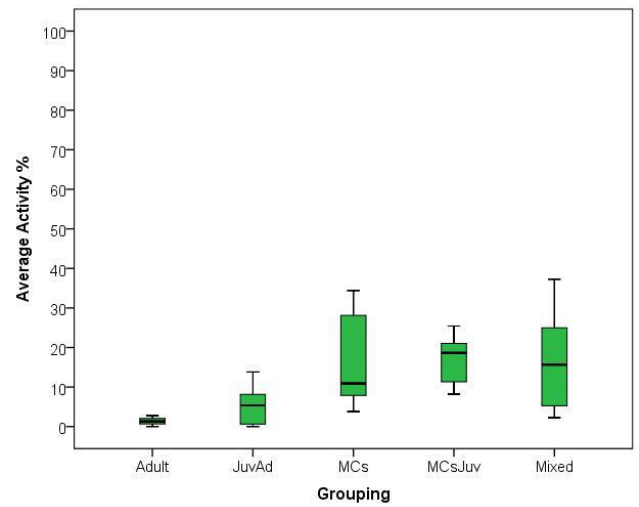
Figure 4. Boxplots of average overall activities percentage per social grouping. Note the scale is a 100%.